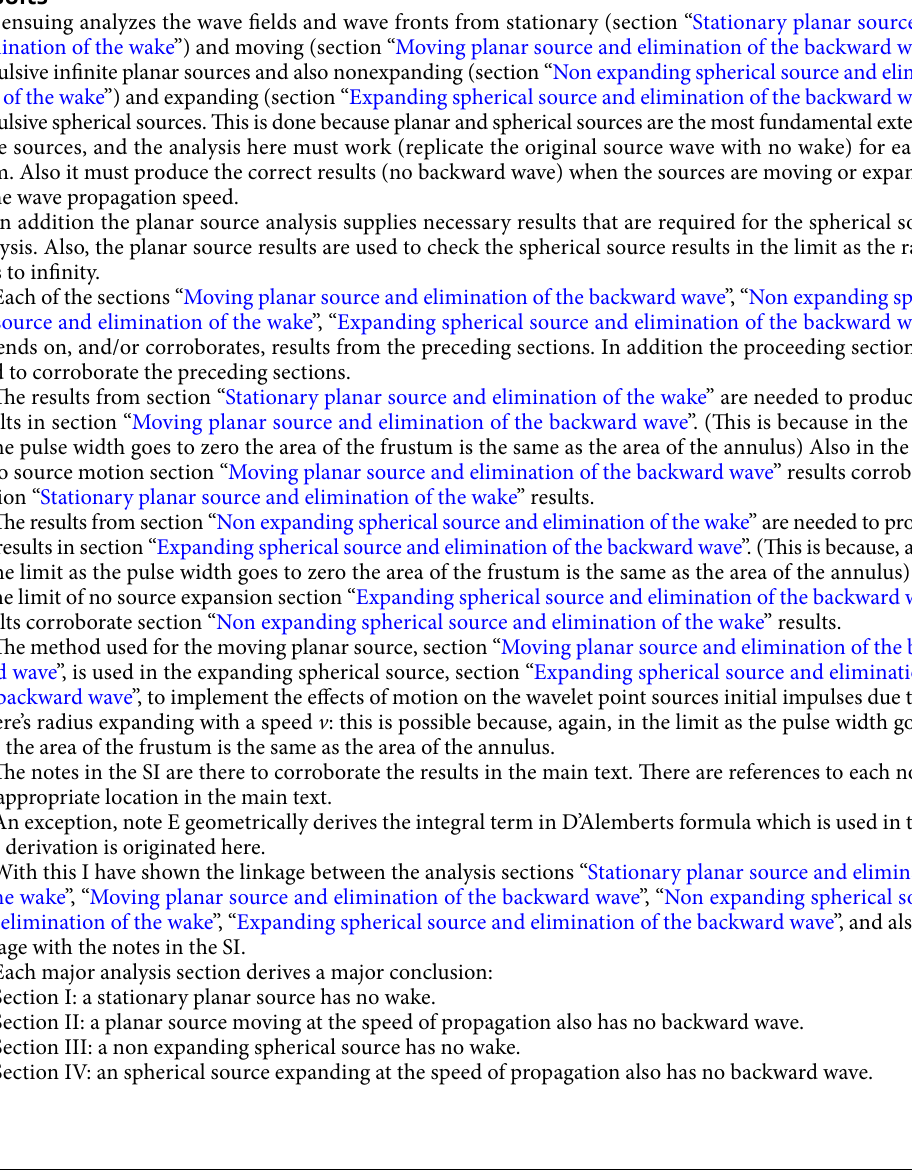
and f is used for wave fronts derived from φ . The symbol δ is used for the Dirac delta distribution and δ f is used for finite approximations to it. The symbol θ is used for the Heaviside step function 36, 37 . All results are in the sense of distributions.